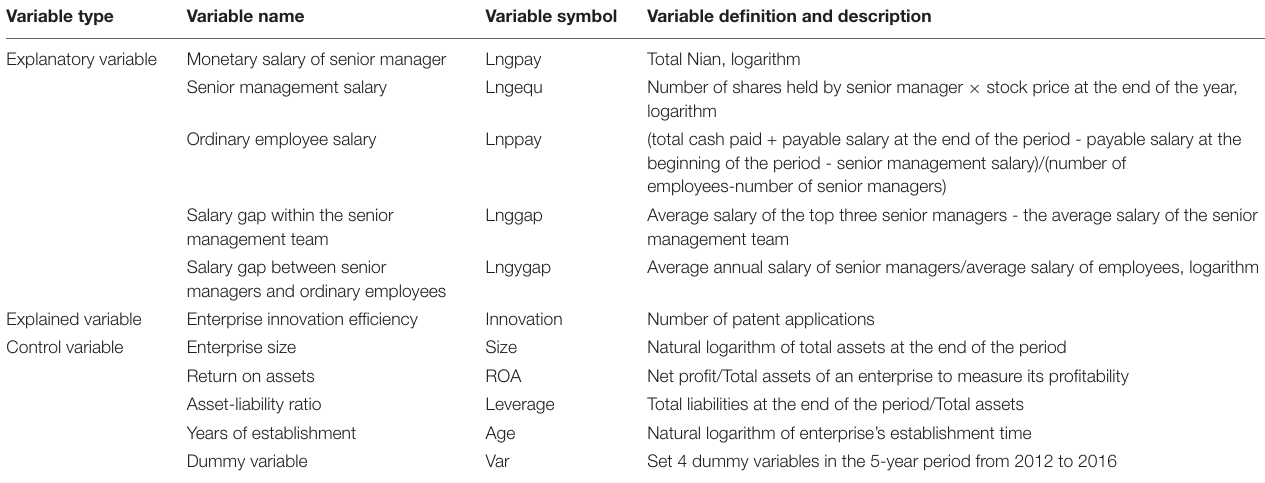
TABLE 1 | Summary of variable